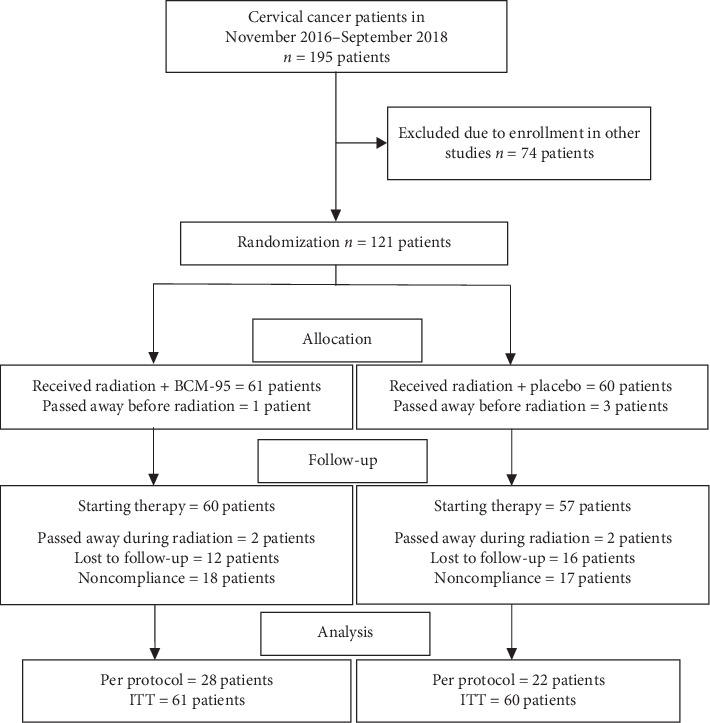
Enrollment and outcomes.